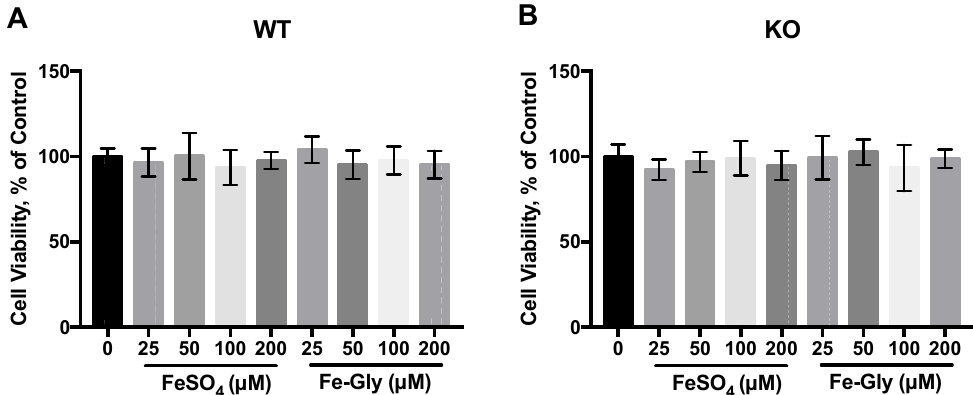
Figure 2. WT: wild-type Caco-2 cell; KO: DMT1-knockout Caco-2 cell. Cell viability of ( A ) wild-type and ( B ) DMT1-knockout Caco-2 cells after 2 hours of iron treatment.